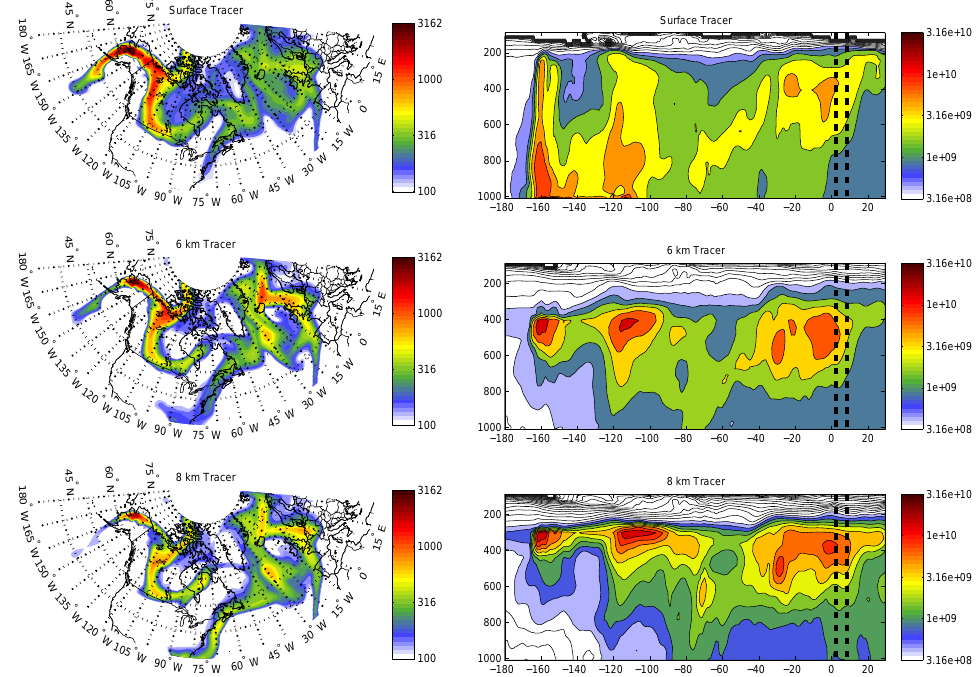
Fig. 14. As Fig. 13 but for 22 July 2004 15:00UTC. Thick black dashed vertical lines represent the locations of Paris (2.5 ◦ E) and Frankfurt (8.5 ◦